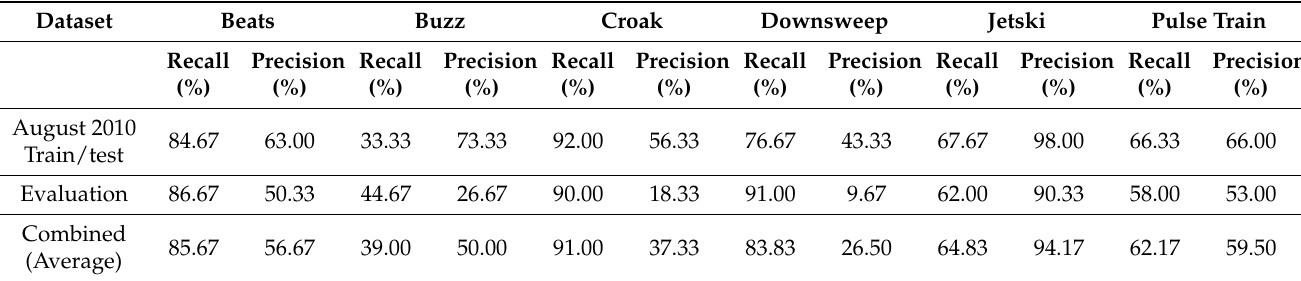
Table 3. The average recall and precision rate (%) for each of the six fish call types for each dataset and the combined average recall and precision for each call type when considering all six trials (three train/test and three evaluation). The average precision and recall values for each call come from Tables S1 and S2 for the train/test and evaluation dataset,